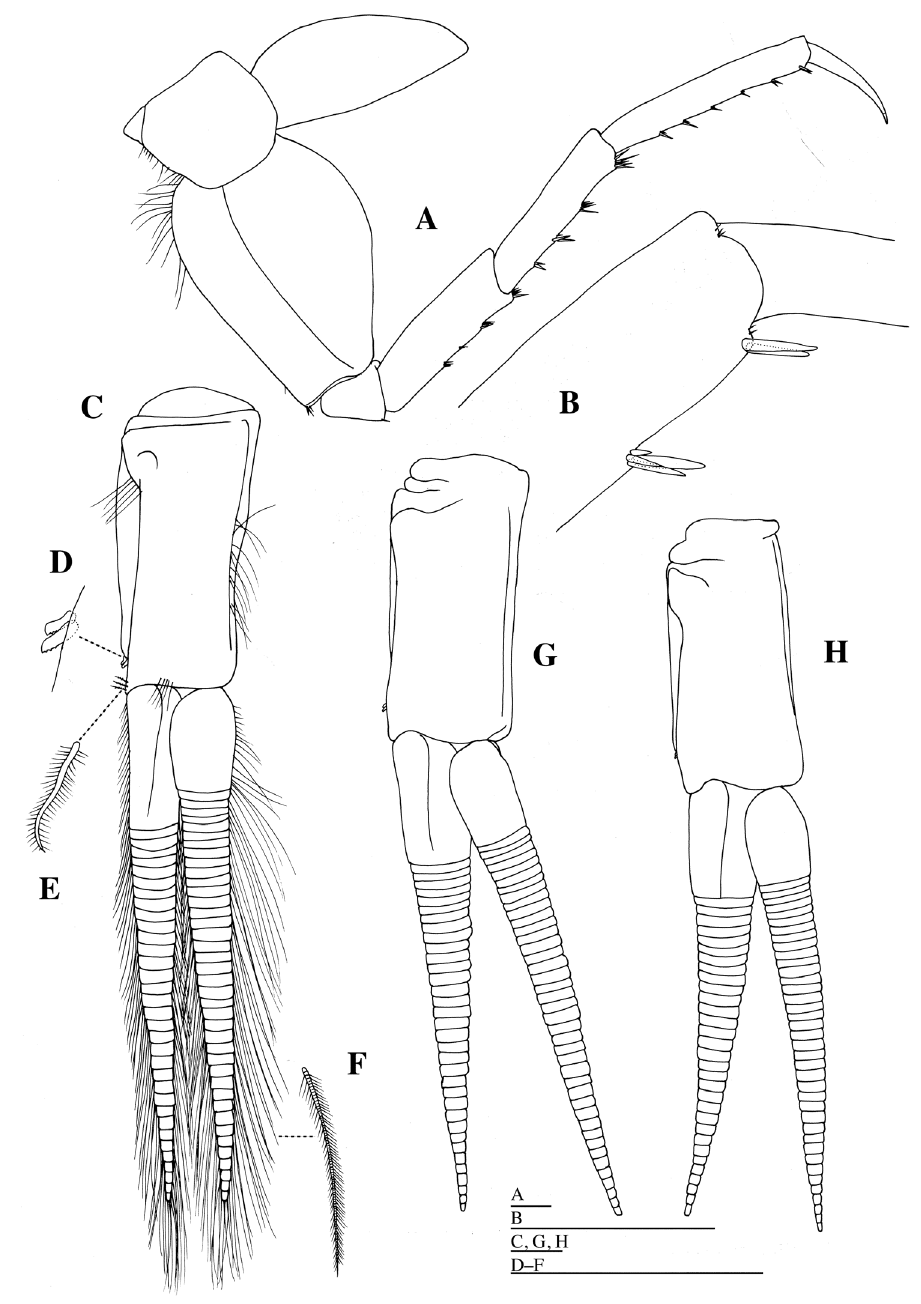
Figure 8. Epimeria abyssalis sp. n., holotype female: A left pereopod 7, lateral B distal part of propodus of left pereopod 7, lateral C left pleopod 1, dorsal D coupling hooks on peduncle of left pleopod 1, dorsal E seta on peduncle of left pleopod 1, dorsal F seta on outer ramus of left pleopod 1, dorsal. Scale bars: 1